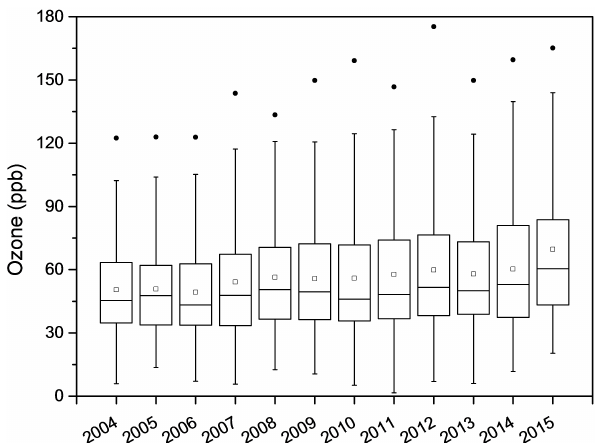
Figure 1. Percentile-box plot of yearly statistics of MDA8 values of ozone at SDZ, in the period of 2004–2015. Boxes depict interquar- tile range and median; the squares depict the mean; whiskers depict 10th and 90th percentile; dots depict maximum